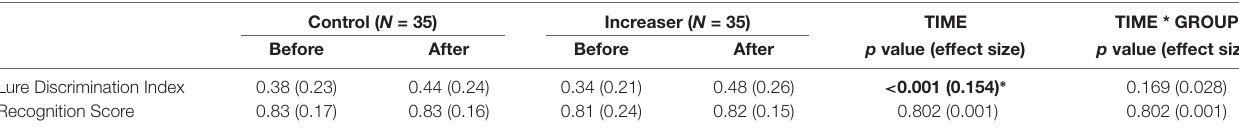
TABLE 6 | Mnemonic similarity task. Control ( N = 35) Increaser ( N = 35) TIME TIME * GROUP Before After Before